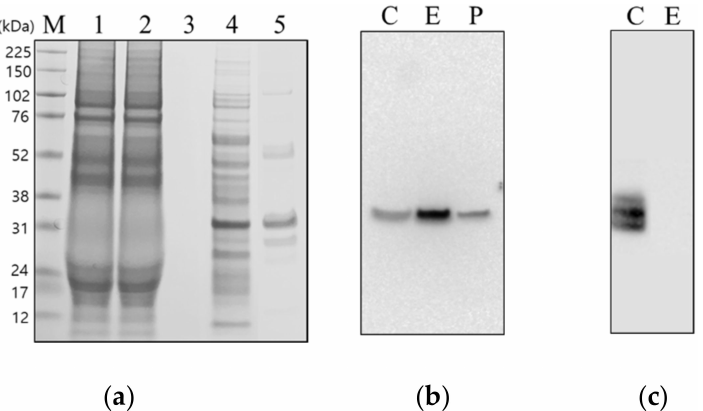
Figure 2. Identification of the purified protein after heparin a ffi nity chromatography. The protein samples of each fraction obtained in the purification process were subjected to sodium dodecyl sulfate–polyacrylamidegelelectrophoresis. ( a )ThegelwasrevealedbyCoomassiebrilliantbluestaining. Lane M, molecular weight marker; Lane 1, foot-and-mouth disease virus serotype O Boeun virus culture supernatant (before column loading); Lane 2, flow-through fraction from the heparin column; Lane 3, washed fraction with the heparin column; Lane 4, eluted fraction from the heparin column (10-fold concentrated); Lane 5, Lane P, positive control (purified FMDV O / Boeun / SKR / 2017 by sucrose density gradient ultracentrifugation). Western blot analysis was performed with ( b ) anti-foot-and-mouth disease virus serotype O VP1. structural protein monoclonal antibodies and ( c ) anti-foot-and-mouth disease virus 3B nonstructural protein monoclonal antibodies. Lane C, foot-and-mouth disease virus serotype O / Boeun / SKR / 2017 virus supernatant; Lane E, eluted fraction from the heparin column (10-fold concentrated).